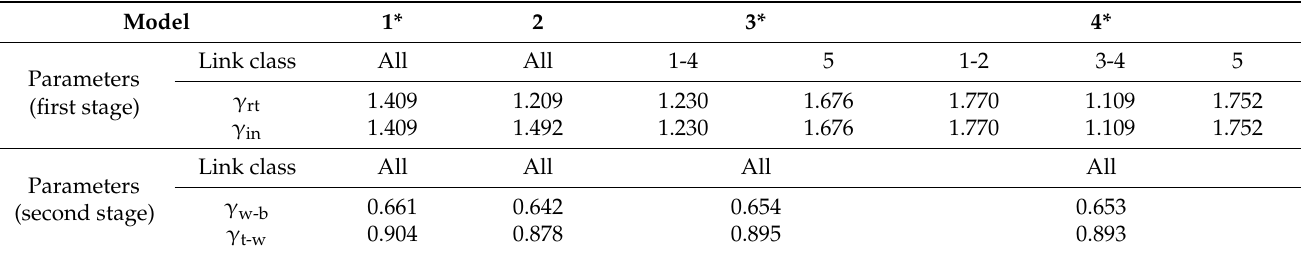
Table 4. Calibration results of vector of parameters γ .